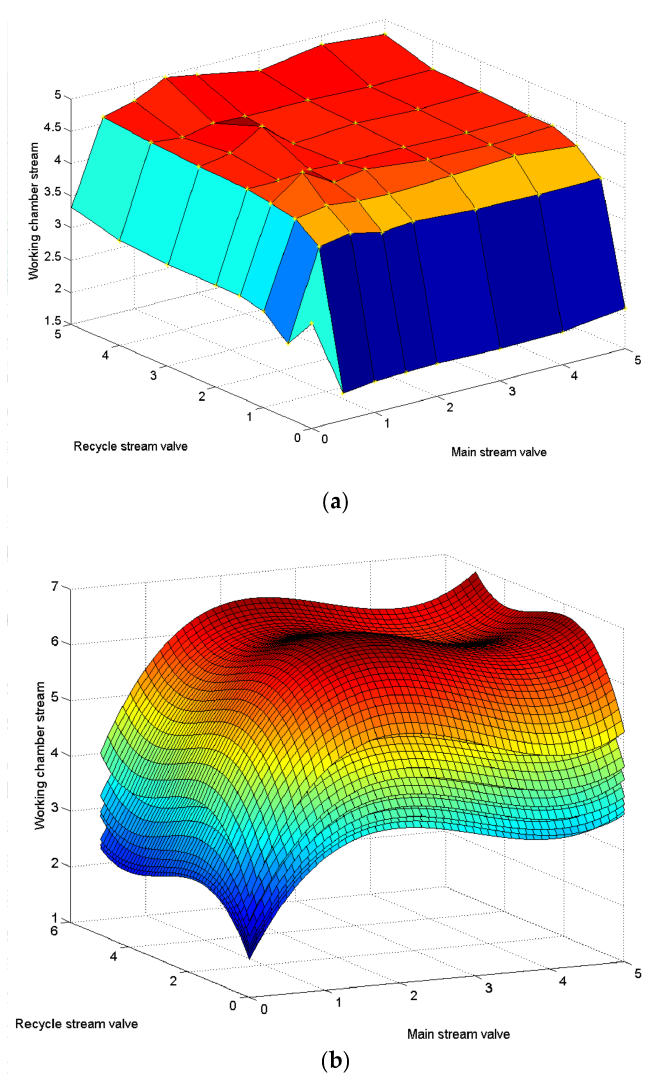
Figure 16. Models for pneumatic transporting system: ( a ) example of data; and, ( b ) model of the working chamber stream. All of the axes are expressed in V as the output of the measurement